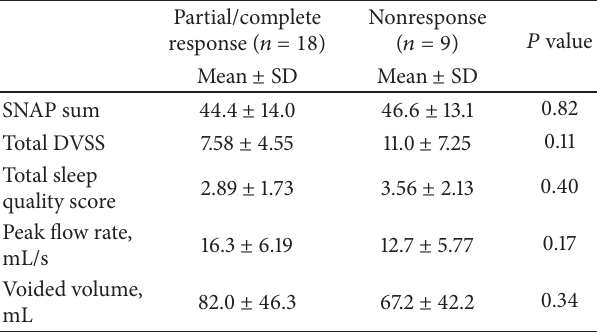
Table 4: Clinical measurements of 27 subjects with ADHD symp- toms categorized by the response to